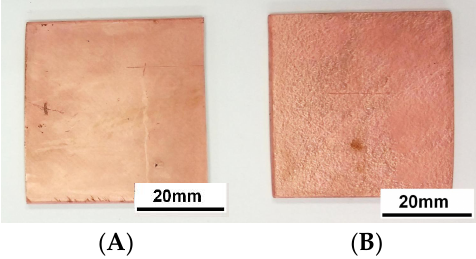
Figure 1. Electroless copper-coated samples. ( A ) Tooling side; ( B ) vacuum bag